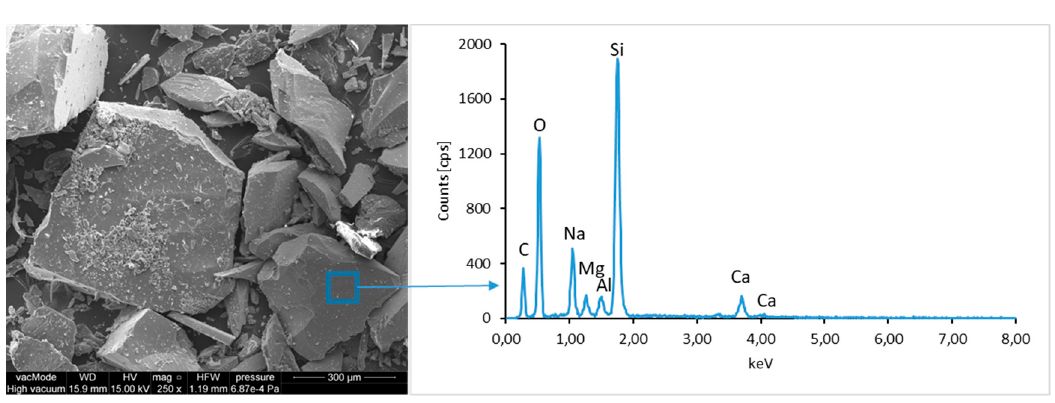
Figure 10. SEM micro-structure of an LCD panel and results of elemental analysis in EDS micro- area. Figure 11. SEM micro-structure of CII.0 concrete and results of elemental analysis in EDS micro- area—compact clusters of C–S–H phase particles can be seen.